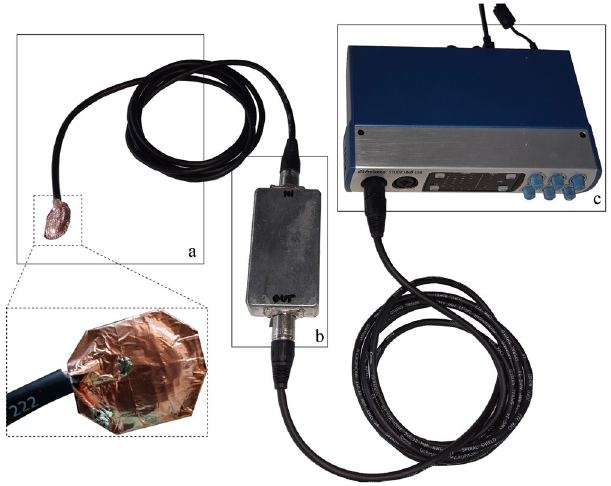
Figure 1. The recording chain consisting of ( a ) a shielded piezo contact microphone, ( b ) an impedance matching stage, and ( c ) an analog/digital conversion and amplification stage which allows to capture recordings from four sensors in parallel.